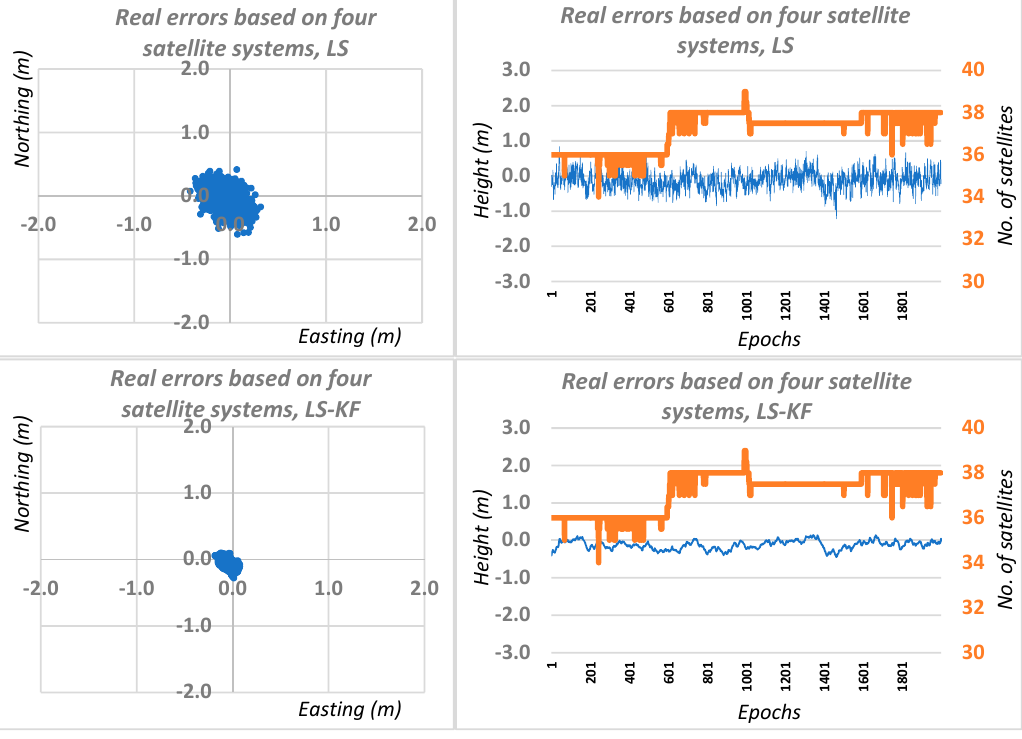
Figure 7. Real errors of the simulated network DGNSS positioning based on least squares solutions and Kalman filtering for four GNSS systems.